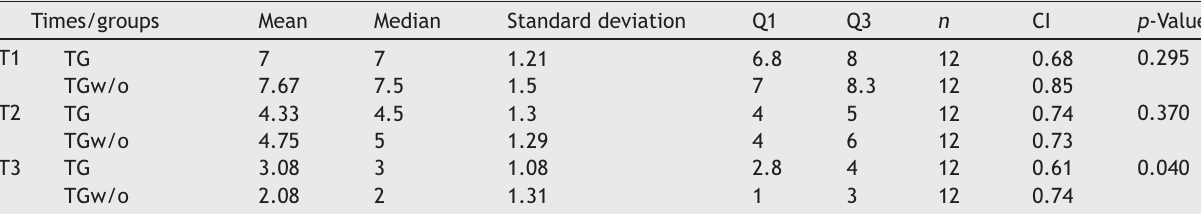
Descriptive statistics and comparative study among groups, by time point, for VAS (uncomfortable with hearing loss).